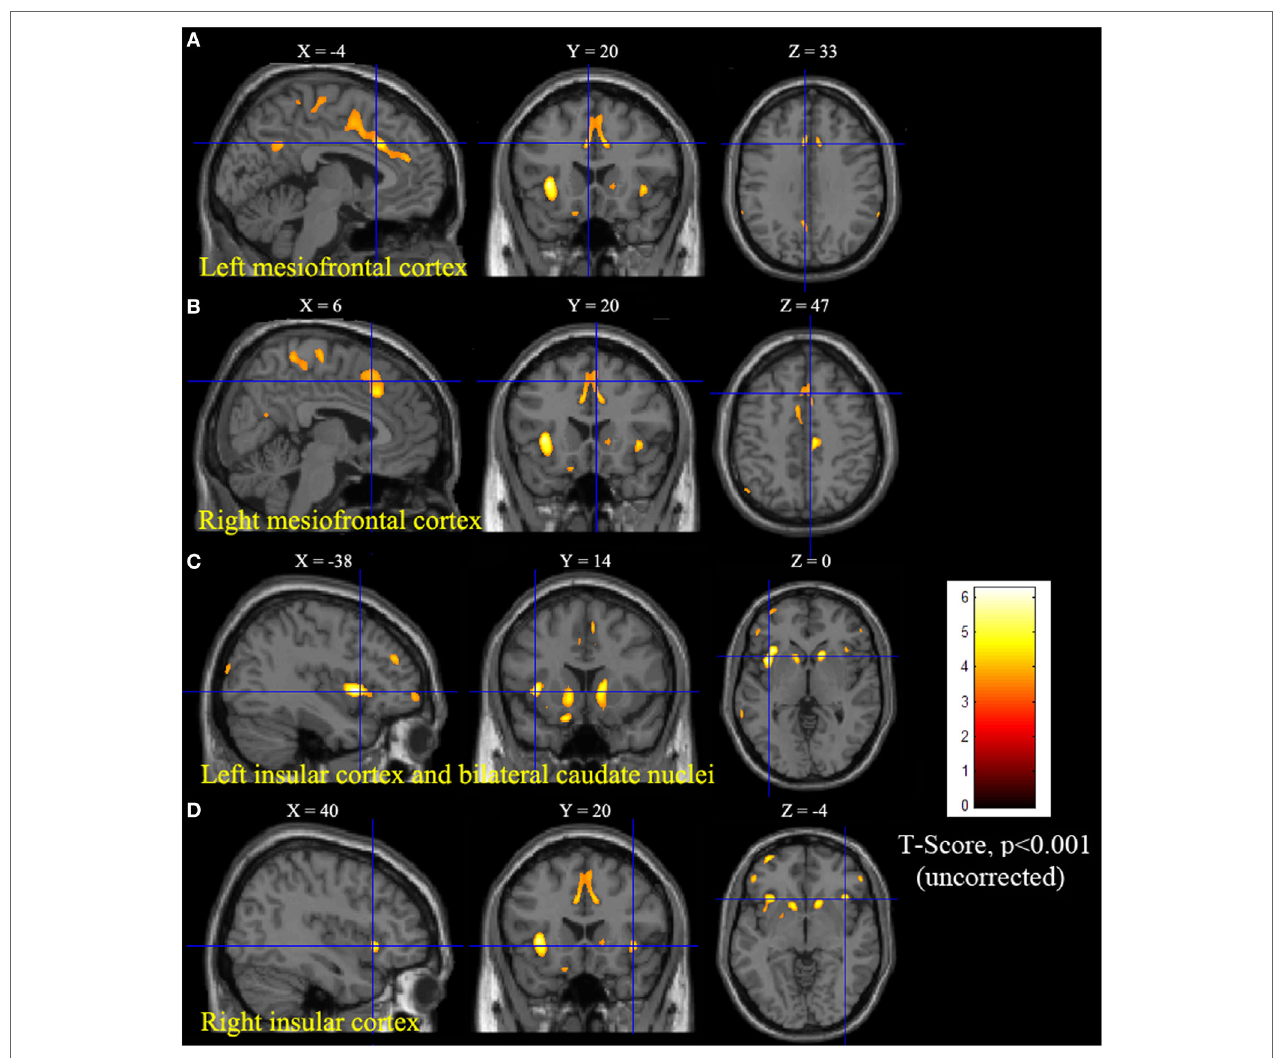
FigUre 2 | Statistical parametric mapping group analysis between patients with hypermotor seizures (HMS) ( n = 14) and a control group ( n = 18). The results showed significant hypometabolism in bilateral mesiofrontal cortex [ (a) left pregenual anterior cingulate cortex, MCC, and mesial premotor cortex (MPMC); (b) right MPMC] and the bilateral anterosuperior insular lobes, the heads of the caudate nuclei [ (c) for left and (D) for right] in patients with HMS. Note that PET images in patients with right-sided epileptogenic zones were transposed horizontally, and all HMS were supposed to originate from the left hemisphere. The color scale means T